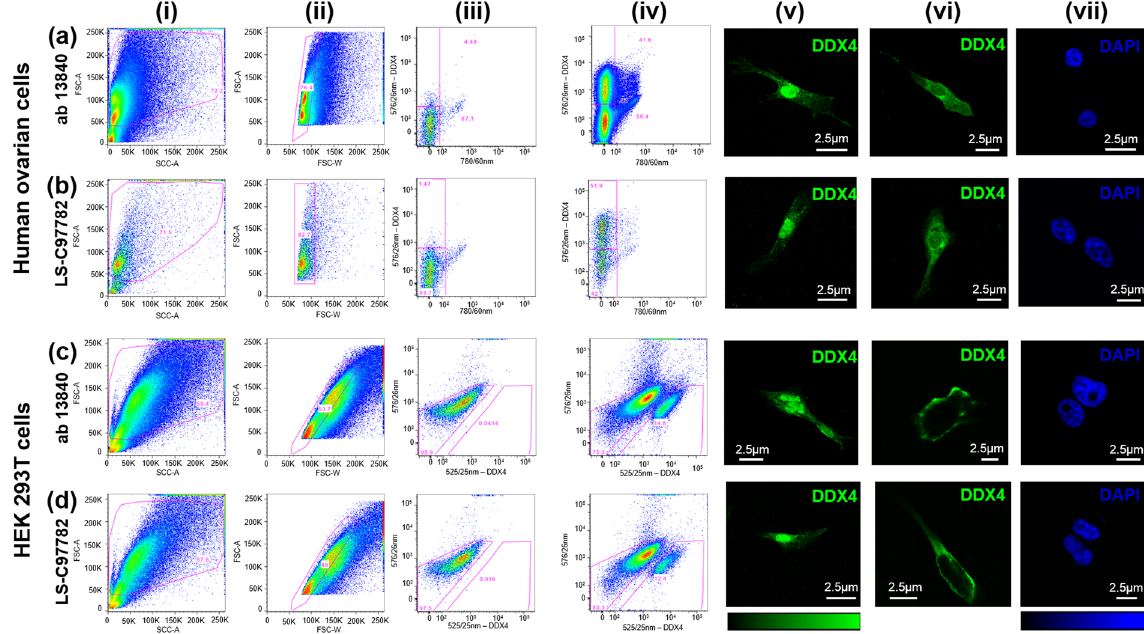
Figure 1. Bivariate flow cytometry plots depicting gating strategies applied to obtain DDX4-positive and negative cells from dissociated adult human ovary and transfected HEK 293T cells. ( a , b ) represents sorts from human ovary using ab13840 antibody ( a ) and LS-C97782 antibody ( b ). (i) Sample of dissociated human ovarian cortical cell suspension. Pink line denotes intact cell gate to exclude cell debris and cell fragments based on forward and side scatter profile (72.2% of total sample in ( a ) and 71.5% of total sample in ( b ). (ii) Intact cell aggregates were eliminated by application of a singlets gate on a FSC-A/W plot, pink line denotes intact single cells (76.4% of total intact population in ( a ); 82.7% of total intact population in ( b ). (iii) Negative control, human cell sample with secondary antibody (anti-rabbit Cy3) only added (no primary antibody). DDX4 gating determined by reference to these samples ( a , b ). (iv) Staining of DDX4-positive human ovarian cell population positive cells are shown within the upper pink gate. In ( a ) 22.9% of sample detected in the positive gate and in ( b ) 30.7% of sample. A minimum of 20000 cells in total was collected from each gate for further analyses. ( a , b v,vi) represents images of fluorescent immunostained cells sorted using ab13480 antibody ( a ) and LS- C97782 ( b ). Positive DDX4 staining (green) is shown in freshly isolated cells (v,vi) and is located in the nucleus, cytoplasm and cell membrane. No DDX4 staining was detected in negative sorted cells (vii) showing DAPI only in blue. ( c , d i–vii) represent the same type of plots and images as ( a , b ) but sorting DDX4 transfected HEK 293T cells where ( c ) has used ab13840 and ( d ) LS-C97782. Gating for DDX4 positive cells is outlined in the pink box on the right of the X axis ( c , d iv). 16.4% of intact singlet transfected cells stained positive for DDX4 in c and 13.4% in ( d ), indicating a similar sorting efficiency of both antibodies. Positive sorted HEK 293T cells stained positive for DDX4 (green; c , d v,vi) but there was no DDX4 staining in the negative sorted cells, stained with DAPI only (blue; c , d vii). X20 magnification, scale bar, 2.5 µ